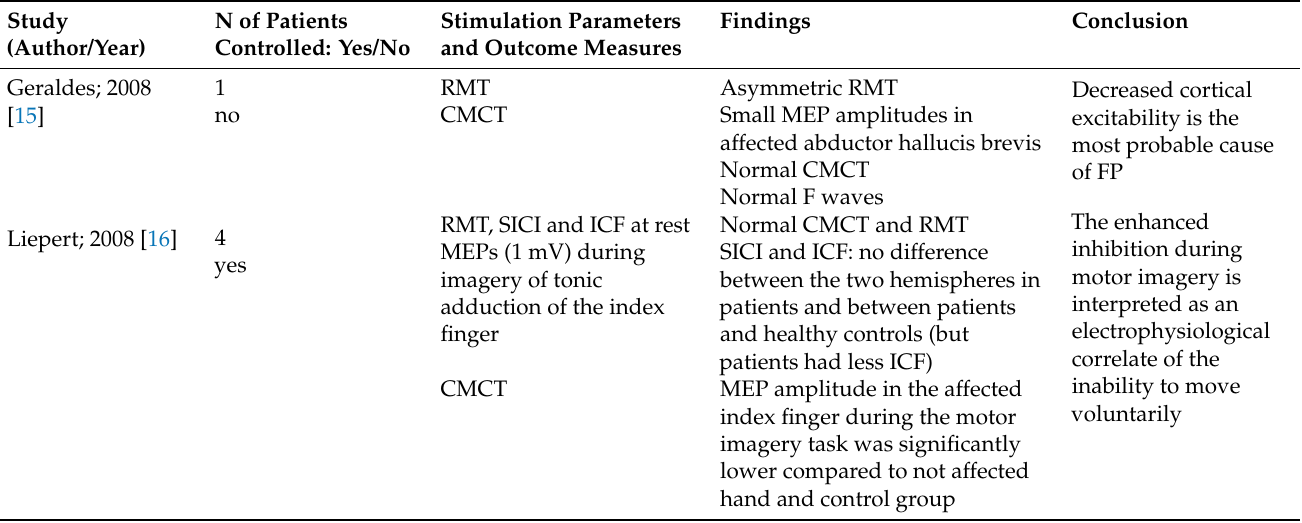
Table 1. Summary of TMS studies investigating the pathophysiology of FP. CMCT: central